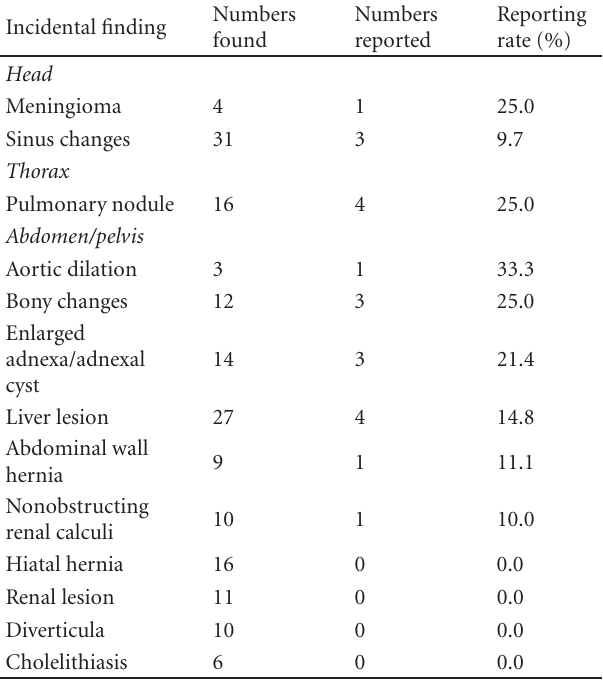
Table 2: Reporting rates for most common incidental